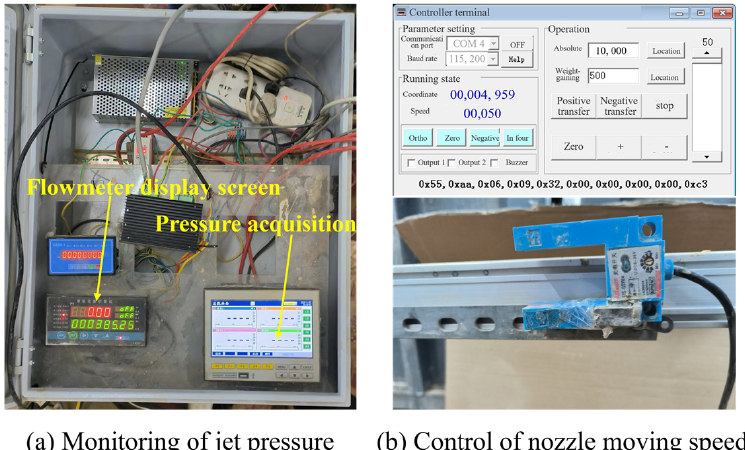
Figure 4. Control and acquisition module.